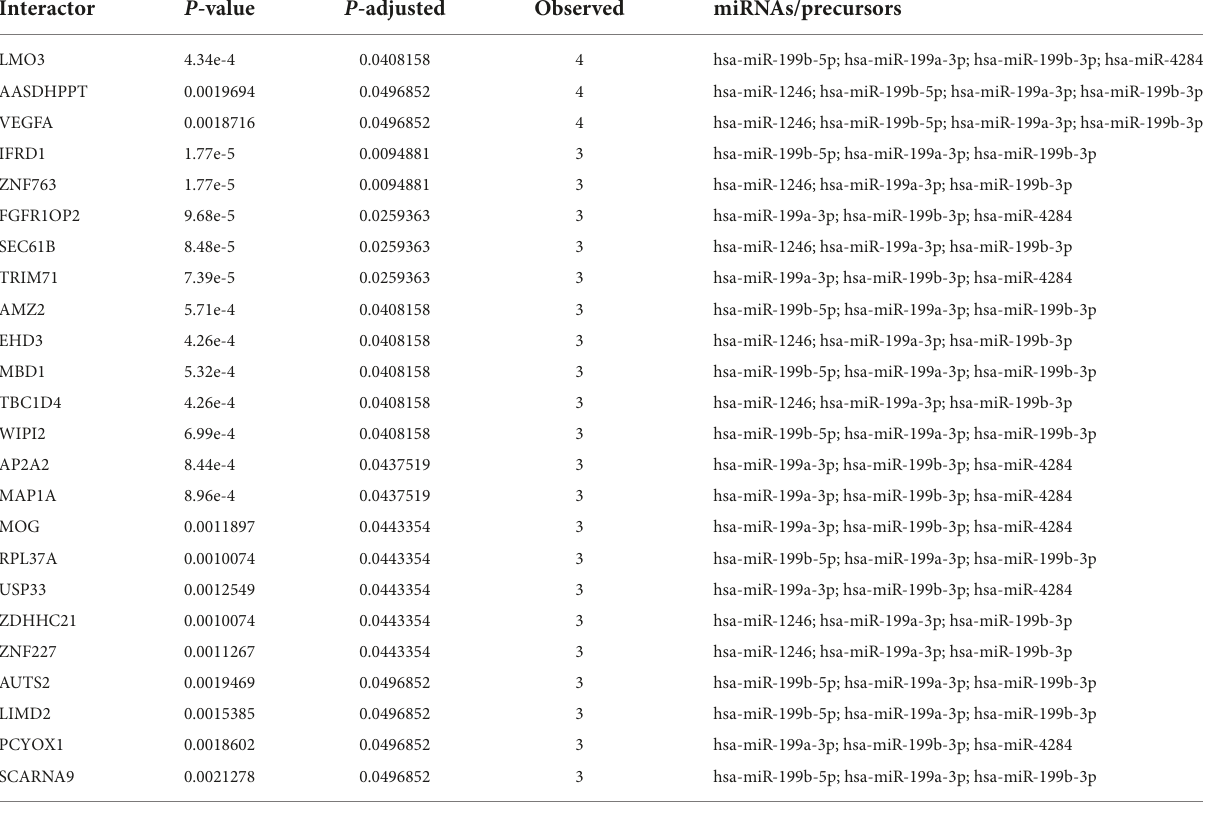
TABLE 8 Interactors of top 10 miRNAs dysregulated.